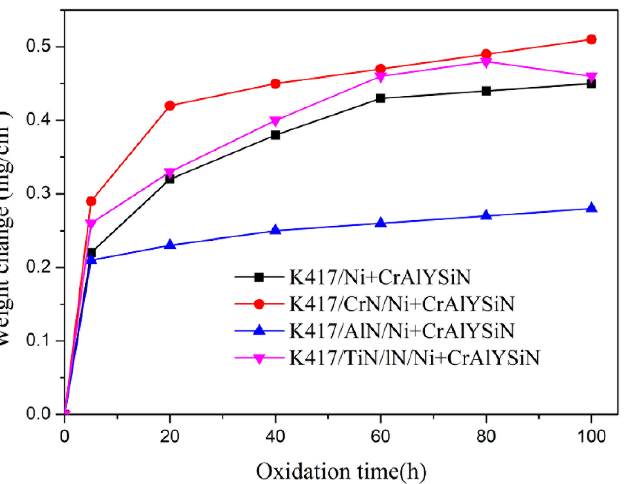
Figure 3. Corrosion kinetics of the composite coating with or without a diffusion barrier after 100 h oxidation at 1000 °C in static air.